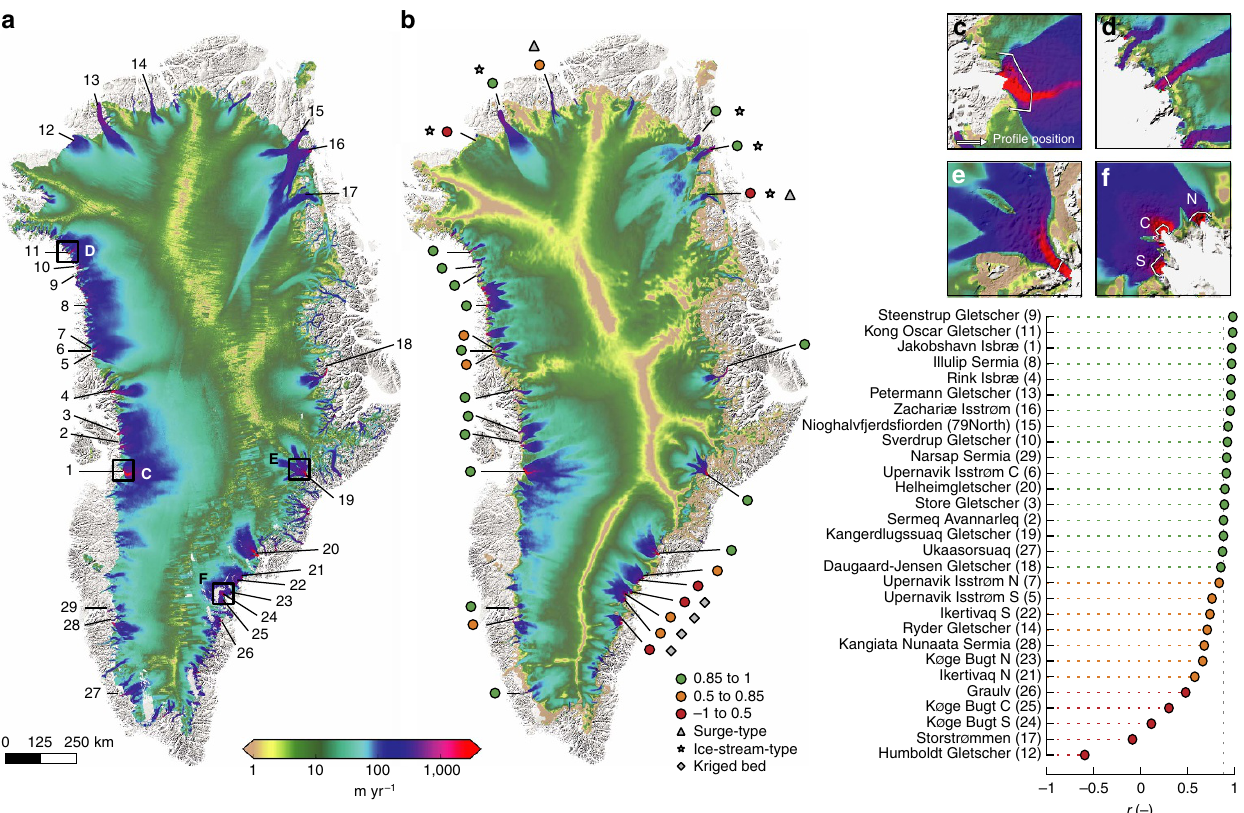
Figure 1 | Surface speeds for Greenland for 2008–2009. ( a ) Observed speeds 12 , adjusted to represent annual averages. ( b ) Calibrated model speeds at 600-m grid resolution. Coloured dots indicate Pearson’s r correlation coefficient and the dotted grey vertical line indicates the median value (0.88). ( c – f ) Inset showing simulated surface speeds of Jakobshavn Isbræ ( c ), Kong Oscar Gletscher ( d ), Kangerdlugssuaq Gletscher ( e ) and Køge Bugt ( f ). White lines indacte the position of the profile. Speeds are masked where observed ice thicknesses are o